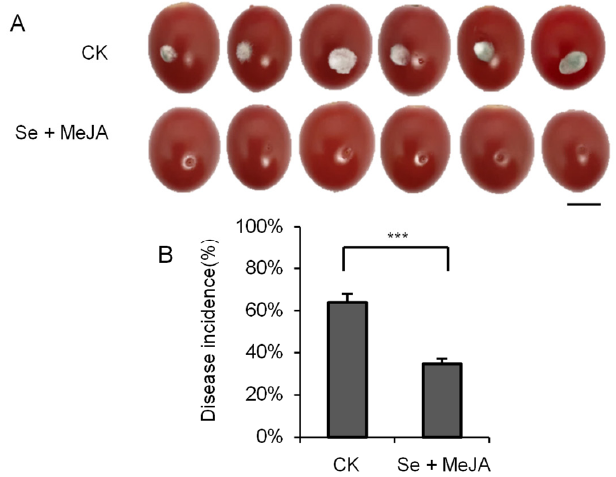
Figure 7. Effect of Se + MeJA on lesion size ( A ) and disease incidence (n = 6) ( B ) of gray mold caused by Botrytis cinerea on tomato fruit after four days of incubation at 23 ± 1 °C. Vertical bars indicate standard error. “***” indicates that there is significant difference between the two groups according to t -test ( p < 0.001). Bars = 10 mm.